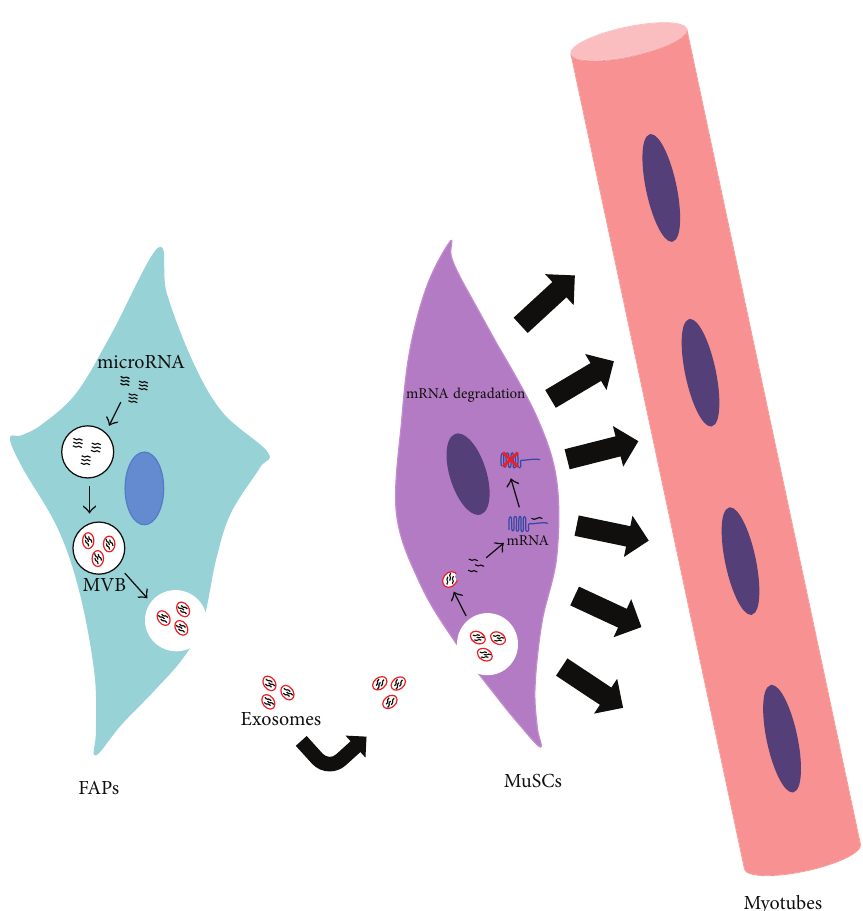
Figure 2: Exosomes as putative mediators of the functional interaction between FAPs and MuSCs. In this model, exosomes released by activated FAPs support myoblasts differentiation through a mechanism by which their cargo of miRNA can be transferred to